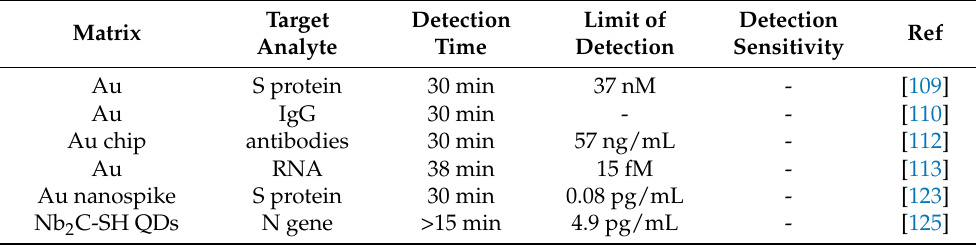
Figure 11. ( a ) Schematic of the synthesis of Nb 2 C-SH QDs (top) and the construction of the Nb 2 C-SH QD-based SPR aptasensor for detecting the SARS-CoV-2 N gene (bottom). Reprinted with permission from ref. [125]. Copyright 2021, Springer. ( b ) The configuration of an SPR sensor based on prism-Ag- Si 3 N 4 -BP-ssDNA. Reprinted with permission from ref. [126]. Copyright 2022, Springer. Table 3. Characteristic parameters of some representative SPR biosensors for SARS-CoV-2 virus de-